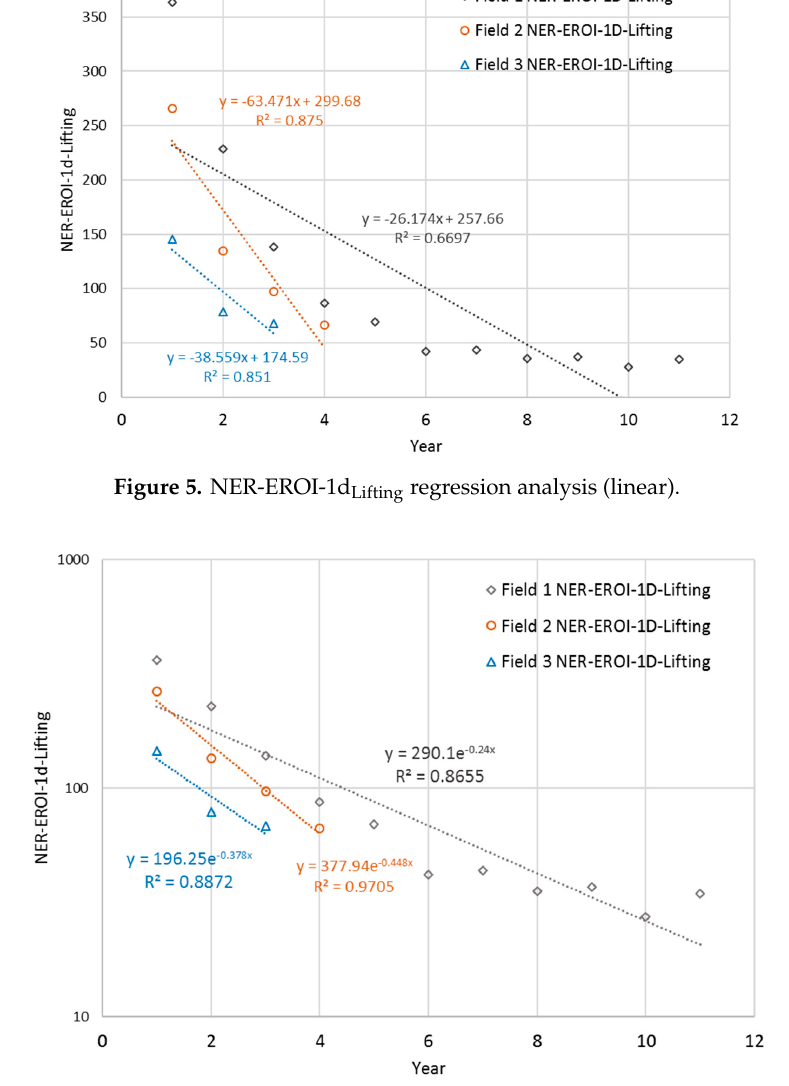
Figure 6. NER-EROI-1d Lifting regression analysis (exponential).